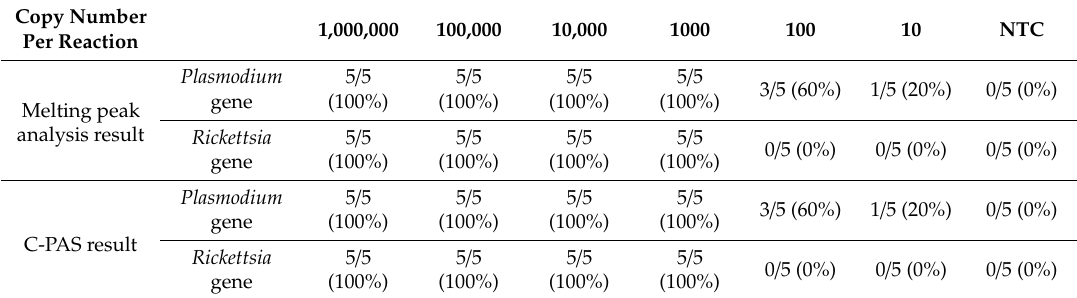
Figure 2. Multiplex LAMP amplification and discrimination by dipstick DNA chromatography (C-PAS) using mixed target gene templates. The reaction mix contained multiplex LAMP primer sets and the two-template mix for Rickettsia and Plasmodium gene target templates ( a ). The amplification curve detected up to 1000 indistinguishable gene copies per reaction ( b ). The melting curve analysis panel shows two melting temperatures for Rickettsia and Plasmodium genes at 87 and 83 ◦ C, respectively ( c ). ( d ) shows the dipstick DNA chromatography panel, indicating Rickettsia and Plasmodium genes, amplified products distinguished as two bands. The C-PAS result is consistent with the melting curve analysis. Table 2. The sensitivity of the multiplex LAMP system based on the melting curve analysis and C-PAS detection technique. Melting curve analysis and C-PAS showed the same sensitivities for detecting synthetic genes of Plasmodium and Rickettsia in five independent experiments. All experiments were performed in five replicates. NTC: no template control.